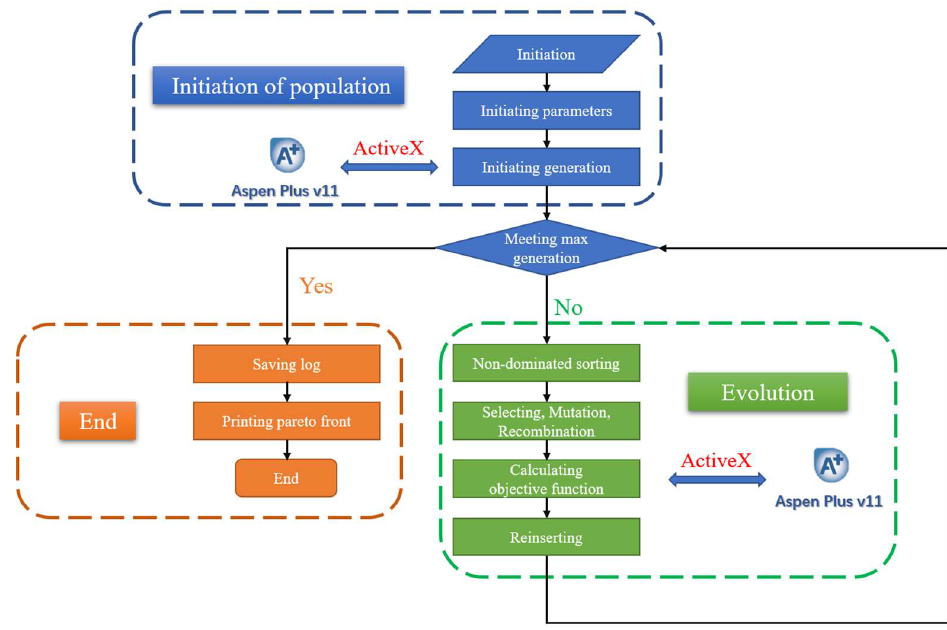
Figure 11. Aspen Plus calculations with NSGA-II-DE for the distillation